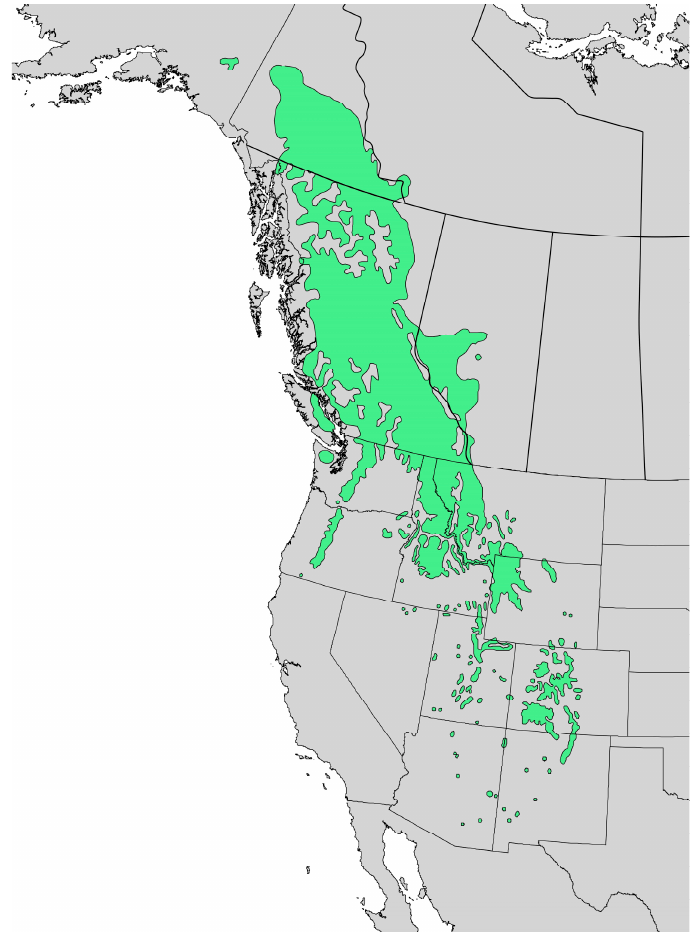
Figure 1. Natural range of Abies lasiocarpa [6].